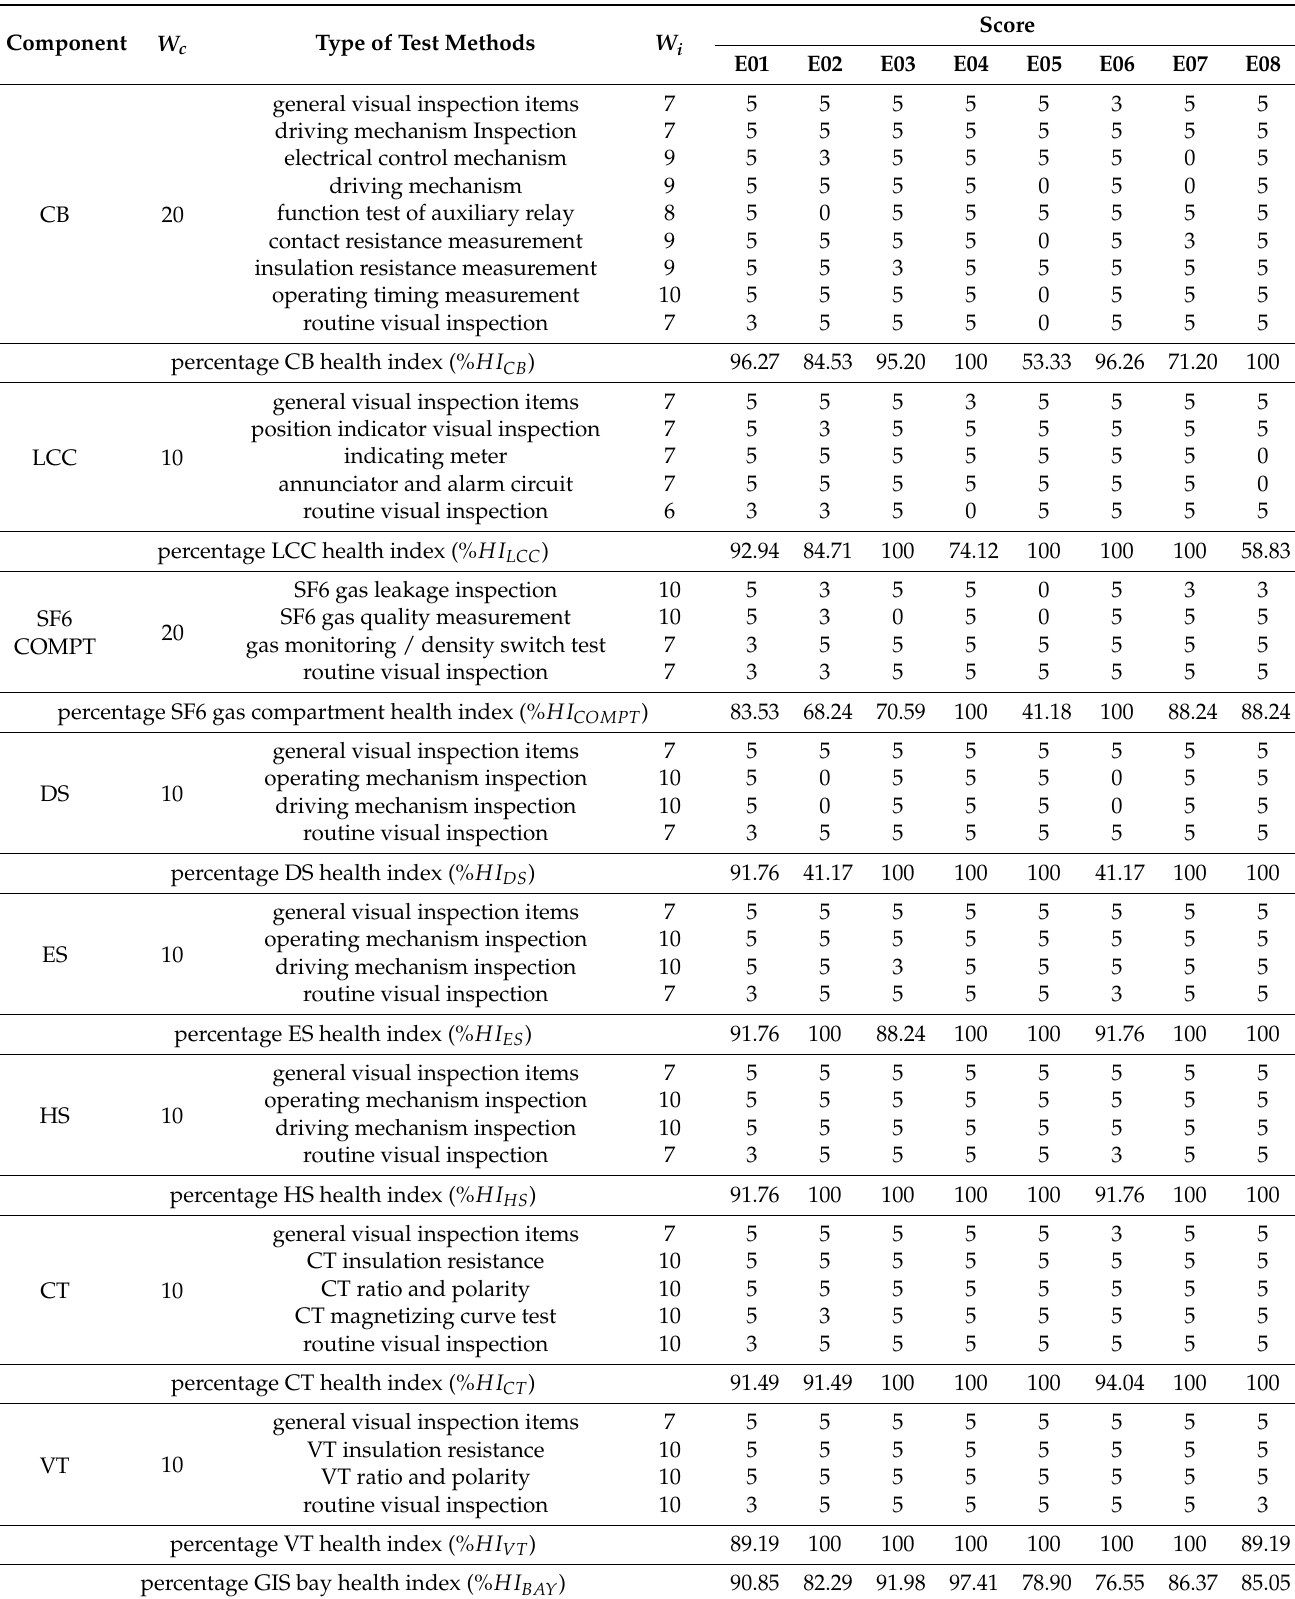
Table 10. Example of component health index evaluation of GIS